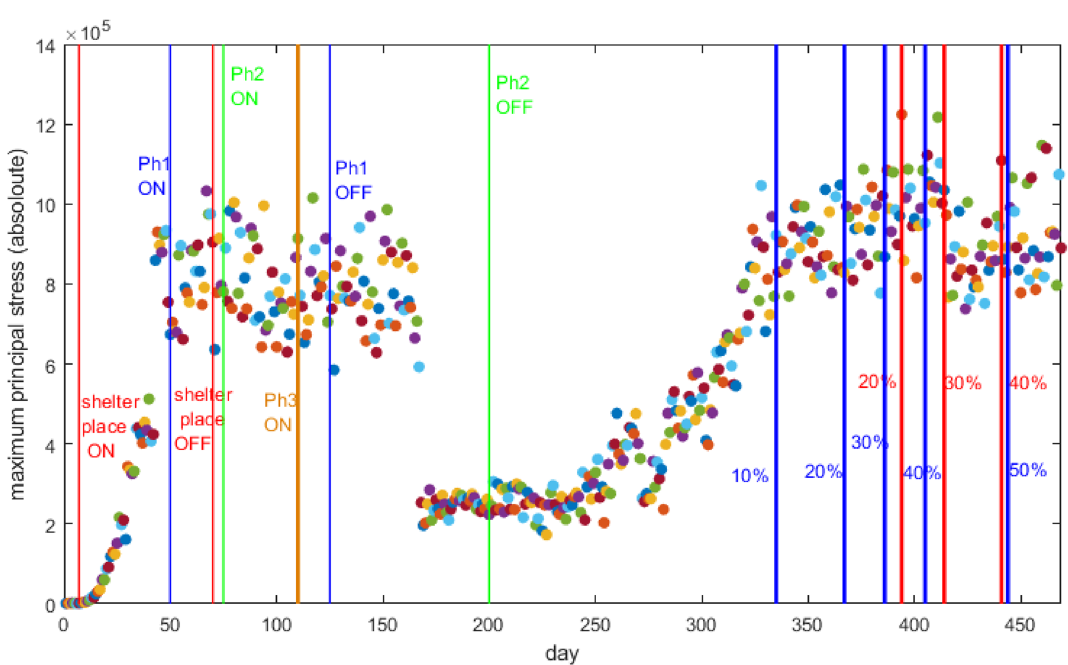
Figure 9. Daily time-series related to cluster j ∈ C and m = | C | = 2 of maximum values of principal stresses of σ 1, s , j , σ 2, s , j , and σ 3, s , j for every active node. The vertical lines represent the events such as start/stop of an executive order, phase declarations, or a milestone in administration of vaccines. We have marked 15 vertical lines, with various color coding. The “shelter in place” ON and OFF “net actions” are marked red, the “phase 1” ON and OFF “net actions” are marked blue, the “phase 2” ON and OFF “net actions” are marked green, the “phase 3” ON “net action” is marked brown, the “At Least One Vaccine Dose” milestones are marked blue, and the “Fully Vaccinated” milestones are marked